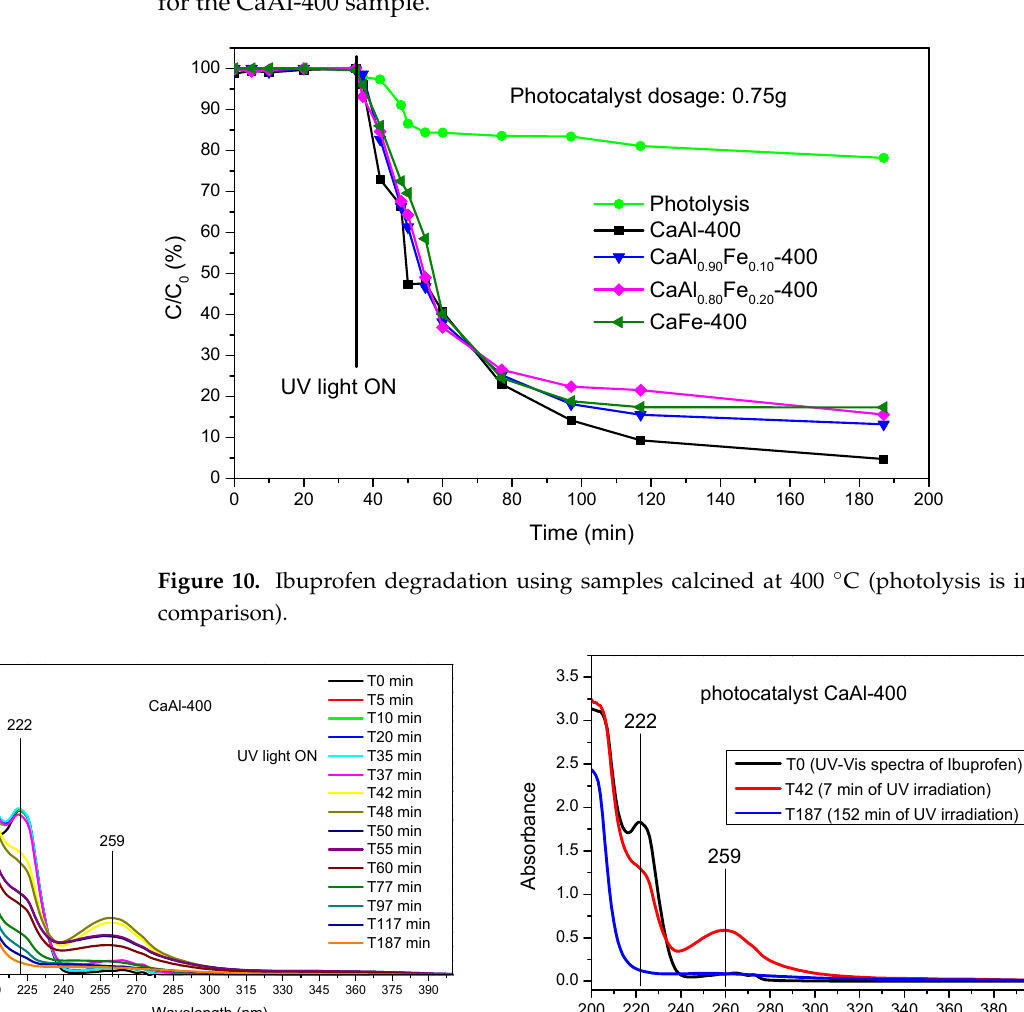
(C 10 H 14 O), hydratropic acid (C 9 H 10 O 2 ), 4-(1-carboxyethyl)benzoic acid (C 10 H 10 O 4